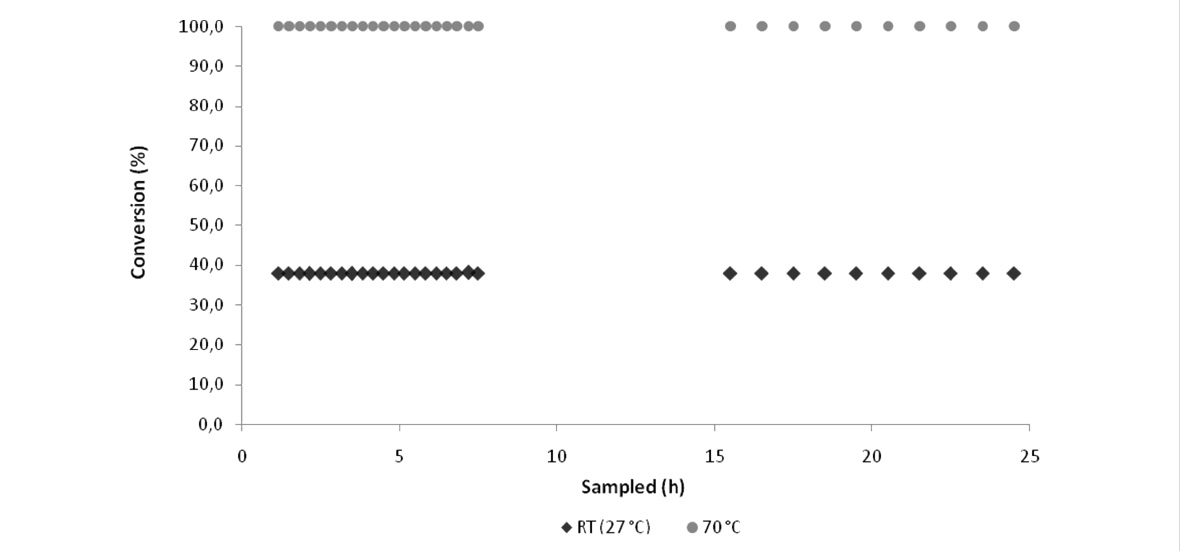
time after only 1 h. Although deactivation of the enzyme was observed at 2.5 and 3.0 M H 2 O 2 ( 2 ), the biocatalyst 4 was found to be tolerant to four times the oxidant concentration (0.2